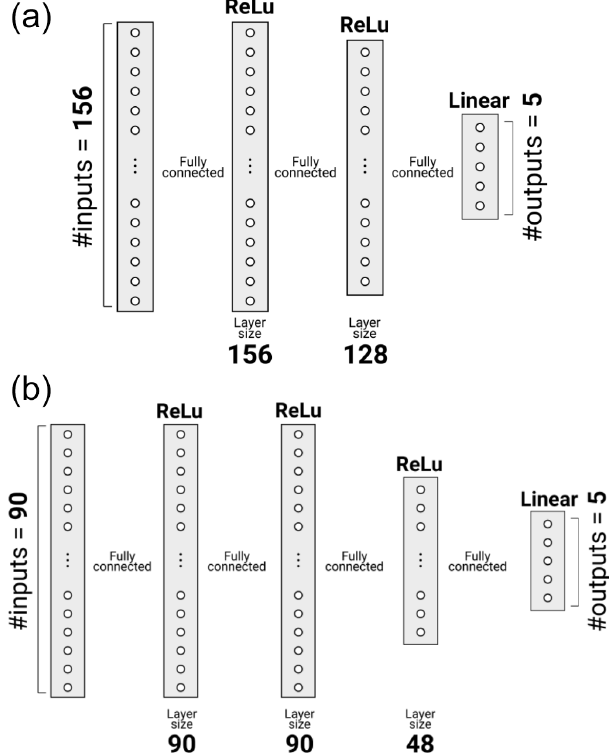
Figure 3. Schematic figure of neural network architectures used. (a) Correction network ˆ e( x ) . (b) Regression network ˆ f ( x )